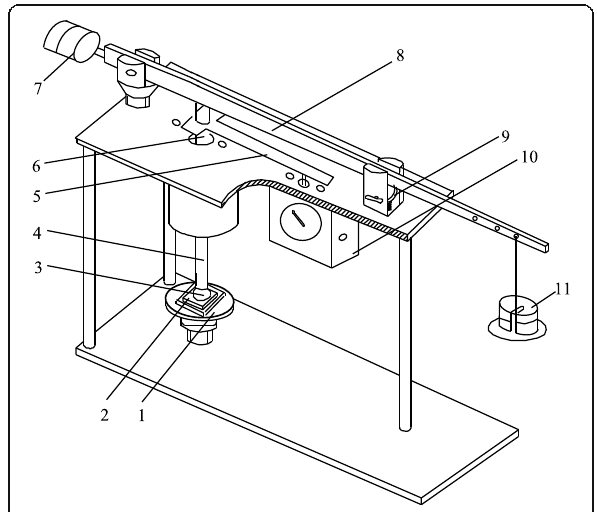
Fig. 1 Schematic view of an installation to study the strain pattern of a leather semi-finished product